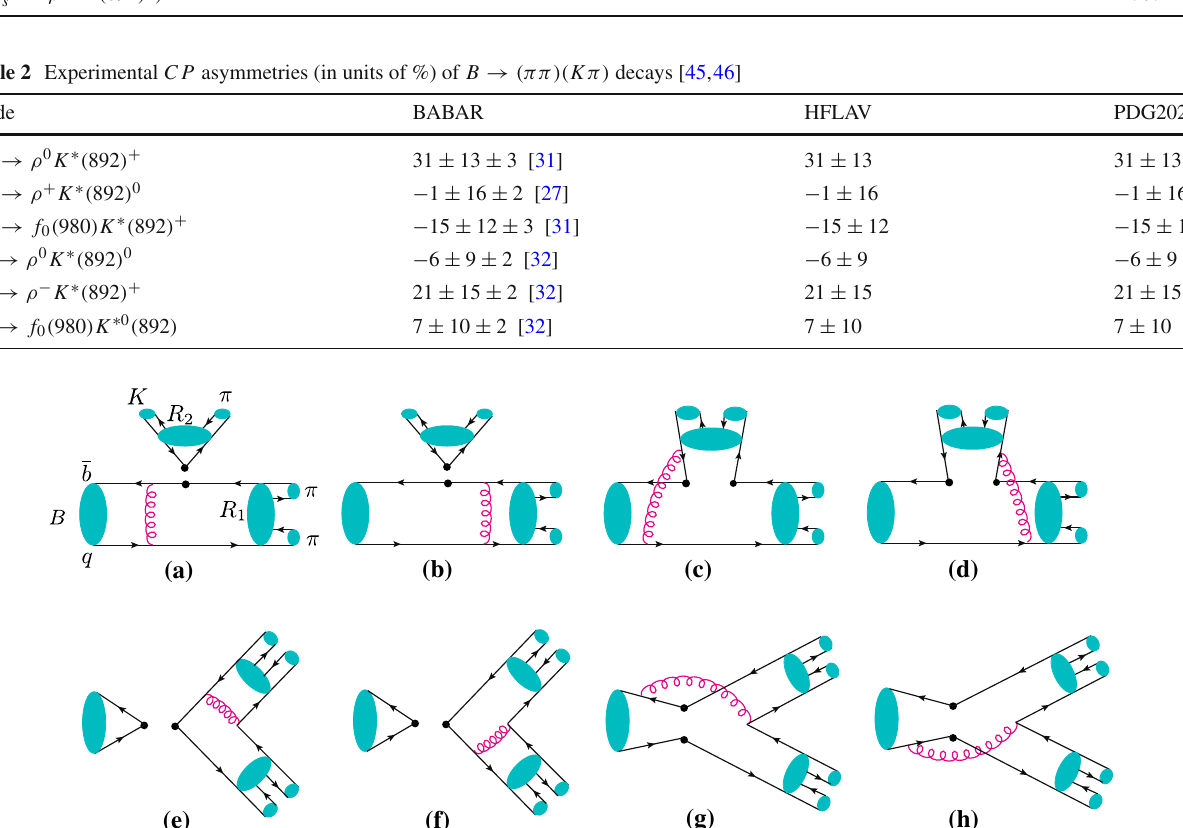
( e )–( h ) for annihilation contributions. If we exchange the position of